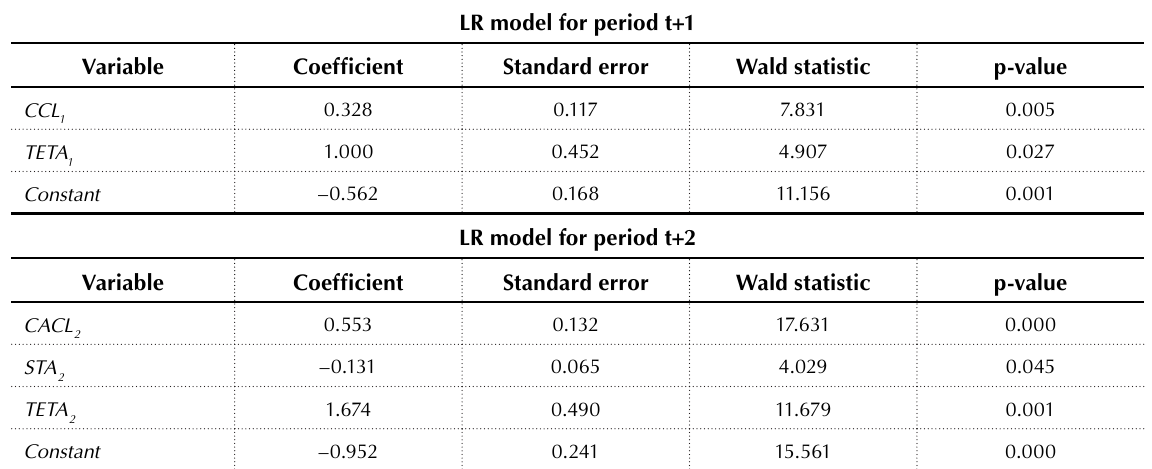
Table 3. Results of weighted logistic regression (LR) analysis for periods t+1 and t+2